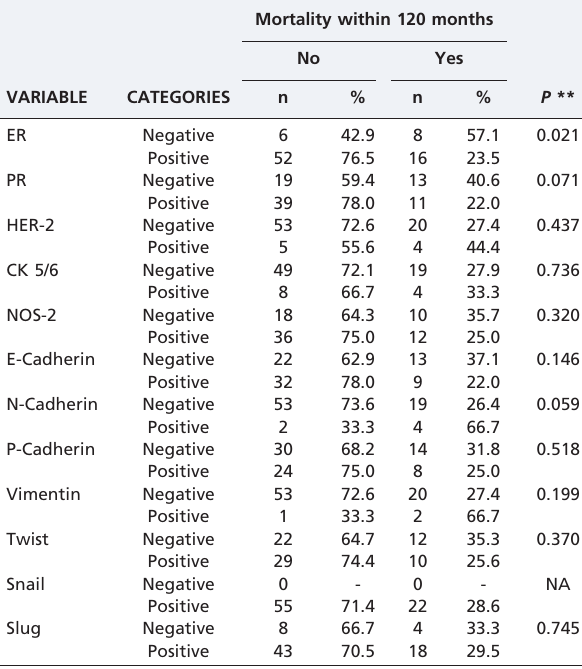
Table 4 - Case distribution according to the phenotypic biomolecular profile and mortality within 120 months of follow-up a among women with stage IIA tumors (n= 82).